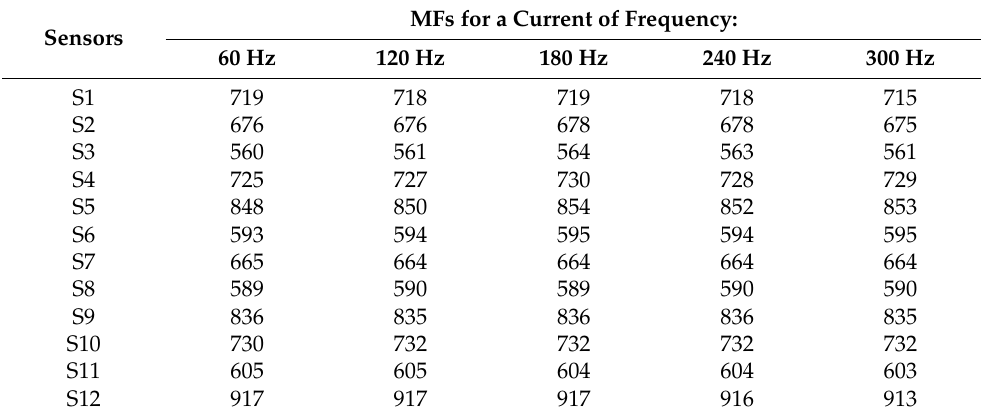
Table 3. Multiplying factors for all sensors with application of 25 A current for various harmonics.